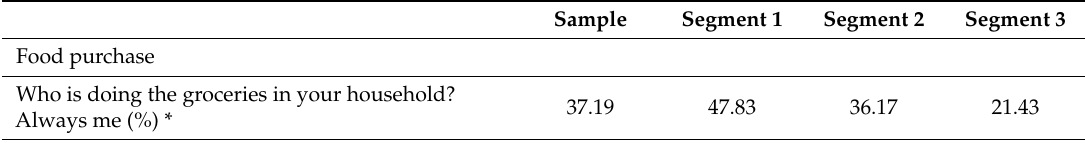
Table 5. Food purchase, knowledge and use of nutritional information.